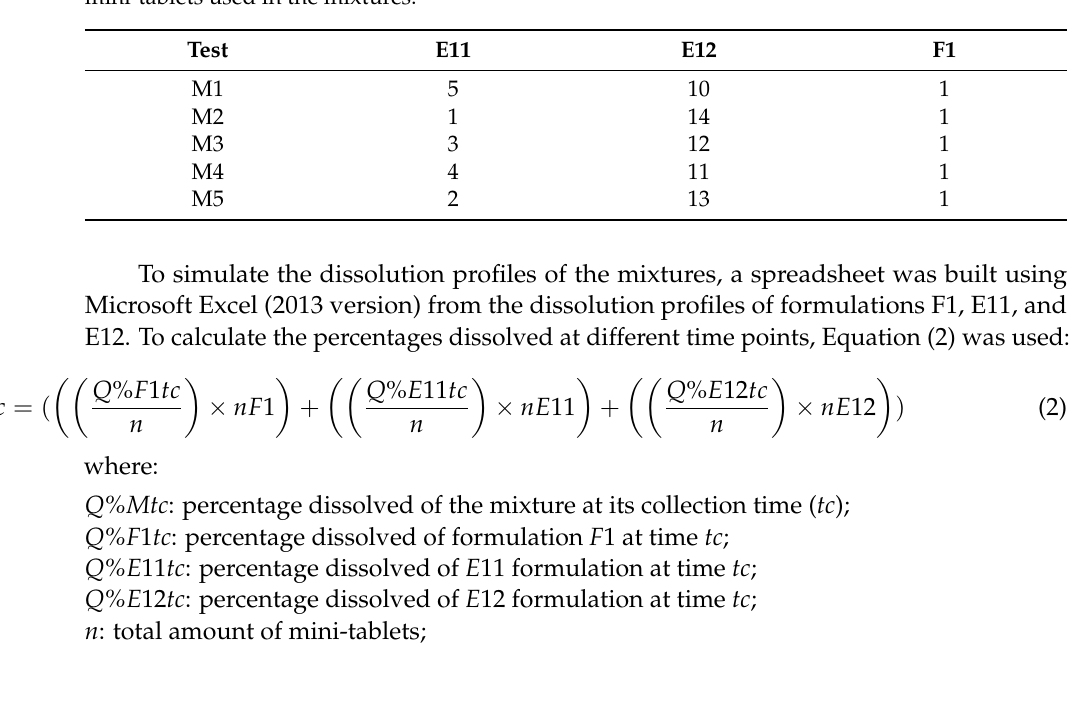
Table 3. Matrix of tests for mixtures of mini-tablets. Levels are shown depending on the number of mini-tablets used in the